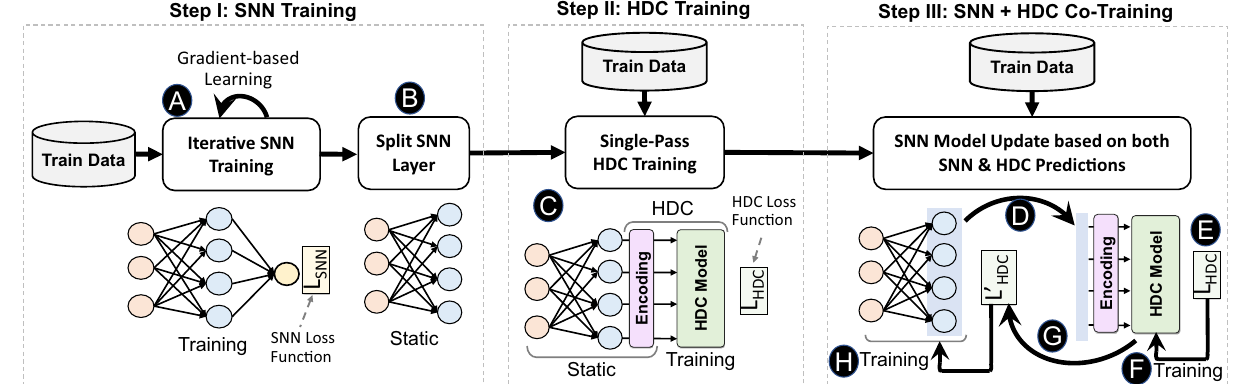
Figure 2. SpikeHD training process: Step I: SNN iterative training. An original instance of SNN is trained without the influence of HDC, in which initial feature extraction recurrent learning from neuromorphic